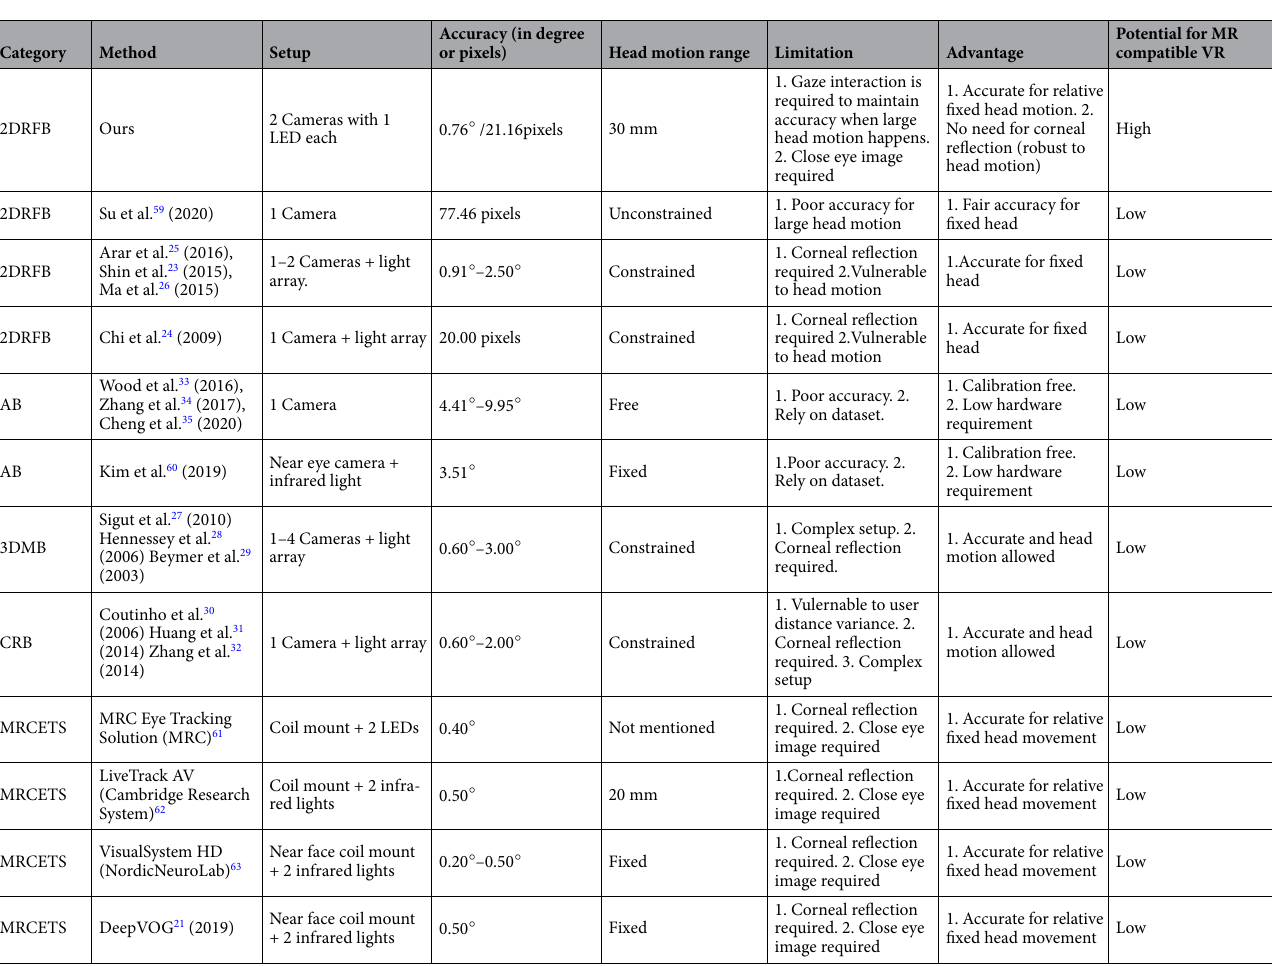
Table 1. Comparison with state of the art methods. We categorize these methods into: 2DRFB = 2D Regression/Feature Based; AB = Appearance Based; 3D Model Based = 3DMB; Cross Ratio Based = CRB; MR Compatible Eye Tracking Software =